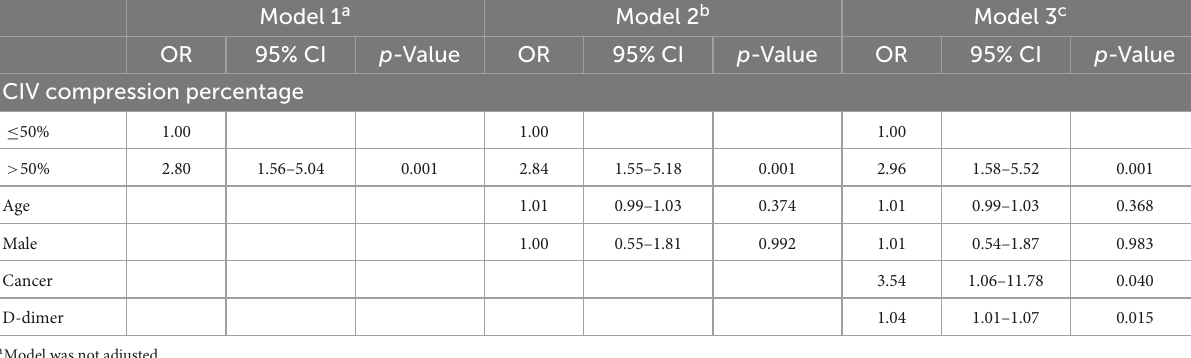
TABLE 2 Logistic regression model for the association between iliofemoral DVT and CIV compression